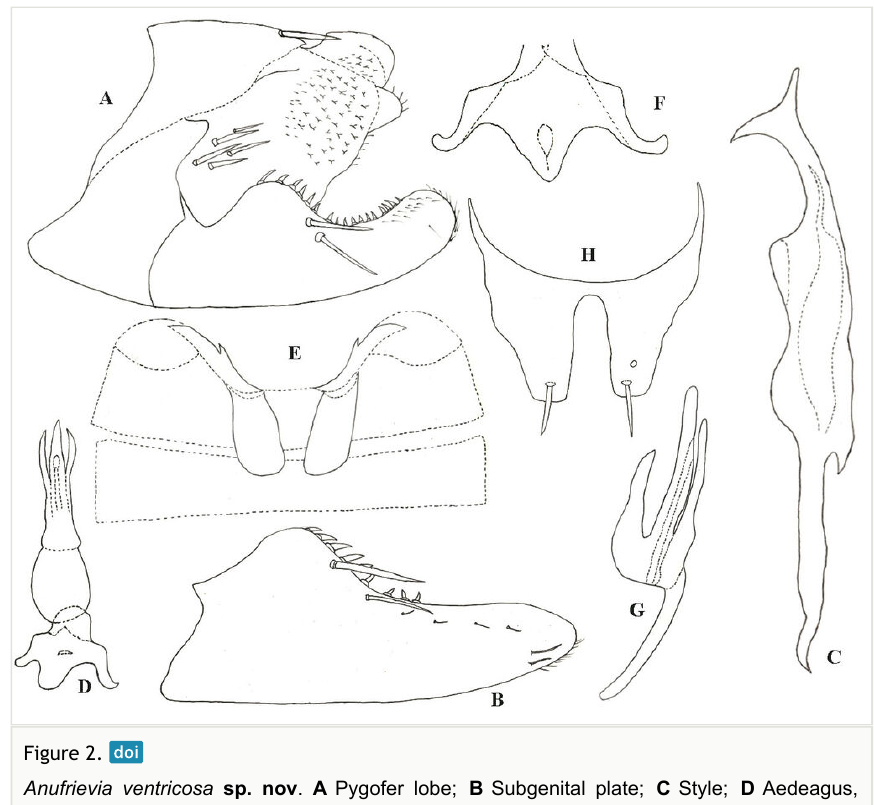
Figure 2. Anufrievia ventricosa sp. nov . A Pygofer lobe; B Subgenital plate; C Style; D Aedeagus, ventral view; E Abdominal apodemes; F Connective; G Aedeagus, lateral view; H Part of pygofer lobe, dorsal